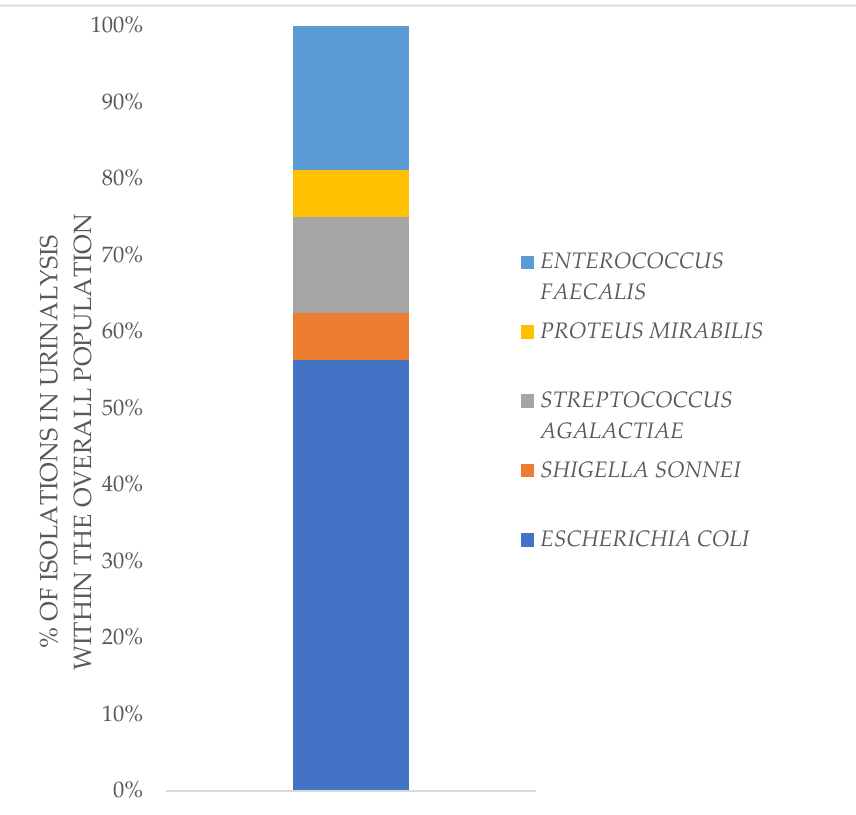
Figure 6. UTIs etiology. Urinary tract infections appear to be mainly caused by agents derived from the intestinal microflora. The main representative was E. coli , but other widely present species included Streptococcus agalactiae , Enterococcus faecalis , and to a lesser extent, Shigella and Proteus mirabilis .